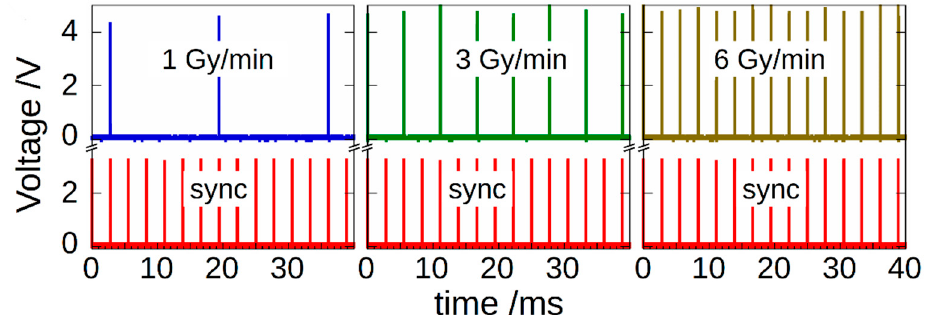
Figure 1. LINAC signal pulses at different dose rates (1, 3 and 6 Gy/min) synchronized with the 360 Hz sync signal (red peaks). Signal pulses are delayed for about 12 μ s with respect to sync pulses rising edge [26]. Note that, in order to maintain the desired dose rate, the system periodically suppresses some pulses.